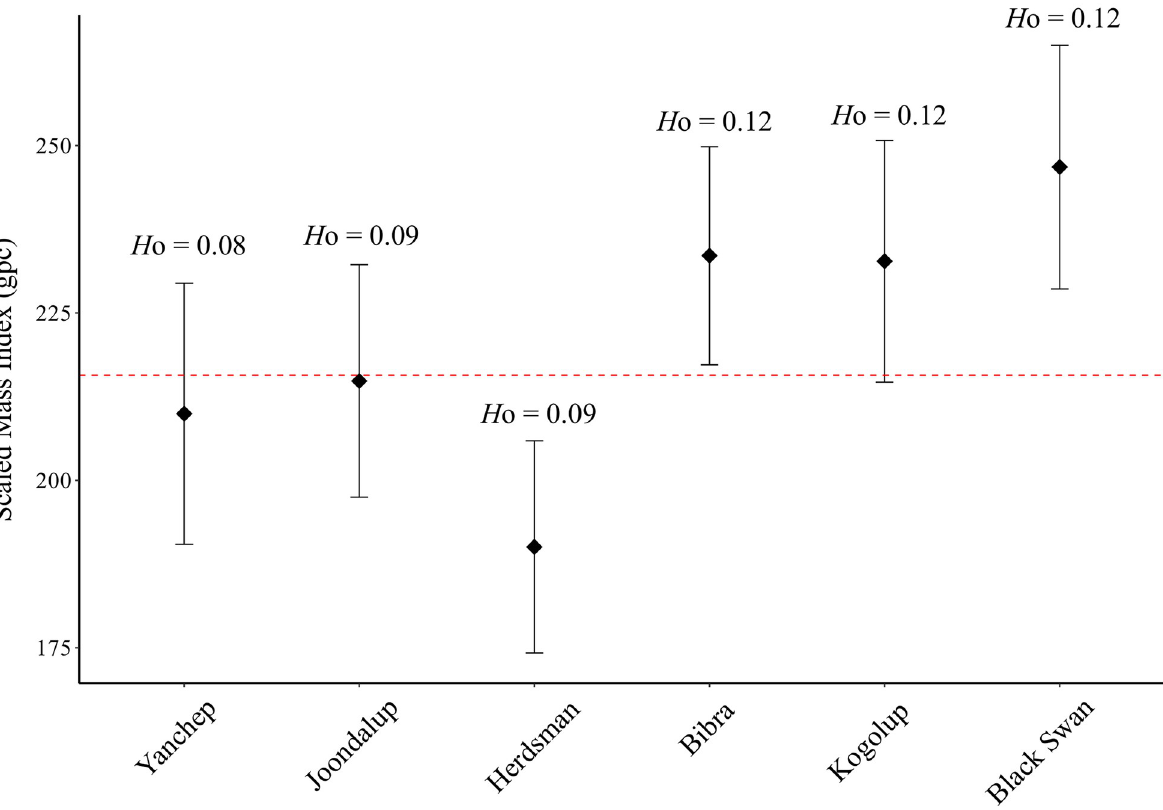
Fig 4. Mean body condition of mainland Notechis scutatus occidentalis populations around Perth, Western Australia. Body condition is presented as scaled mass index (SMI). gpc, grams per cm; filled diamonds are the population mean; error bars represent 95% confidence intervals; dashed line is mean SMI of 215.7 gpc at the mean population SVL of 757.1 mm; H o is the mean observed heterozygosity for each